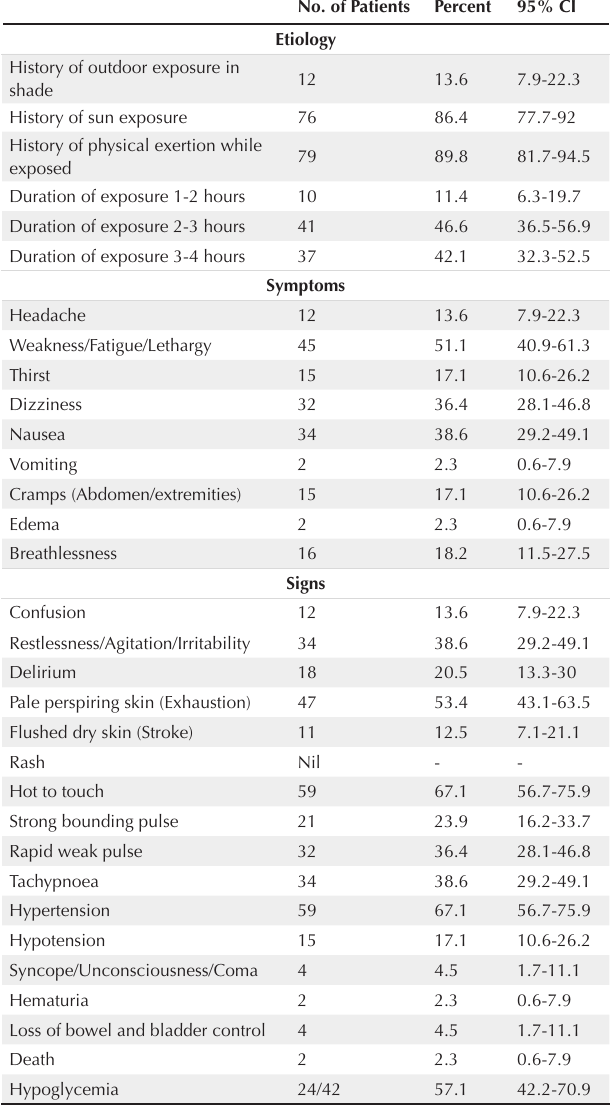
Table 2. Etiology and Clinical Features of Heat Illness and Pre-Existing Health